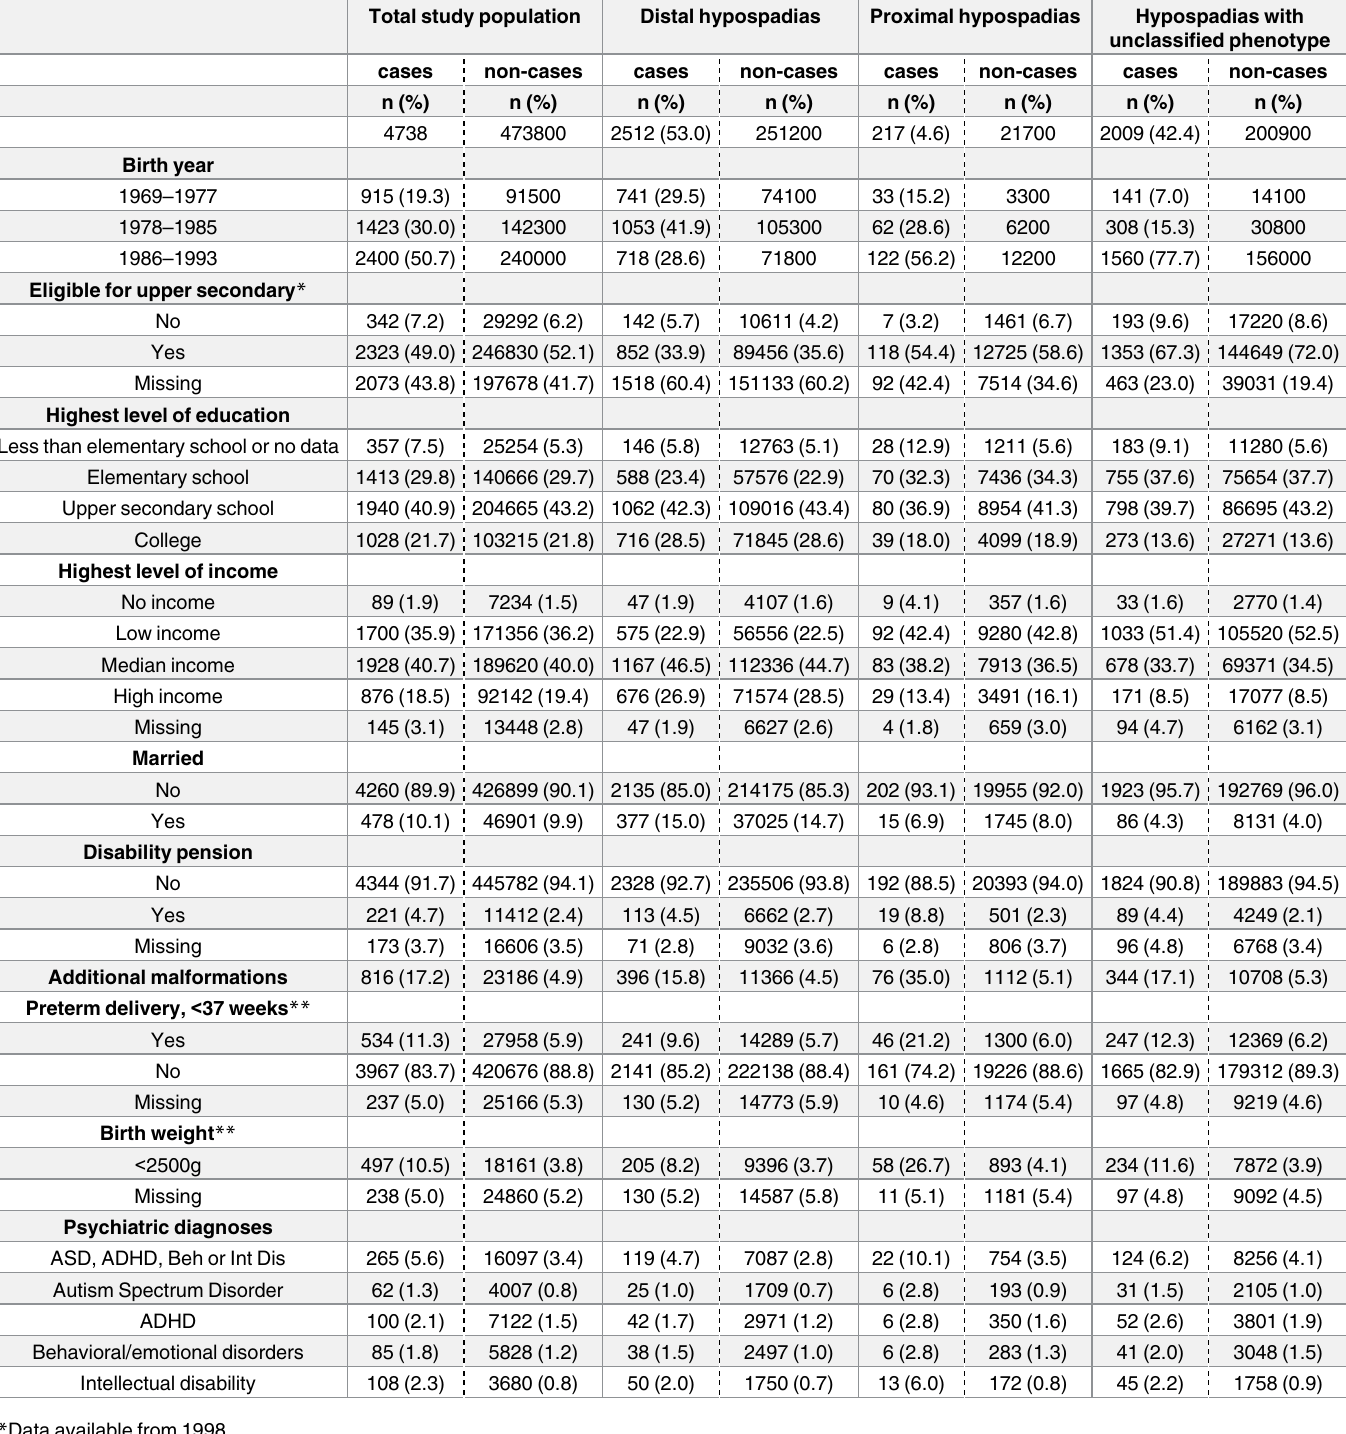
Table 1. Characteristics of the study